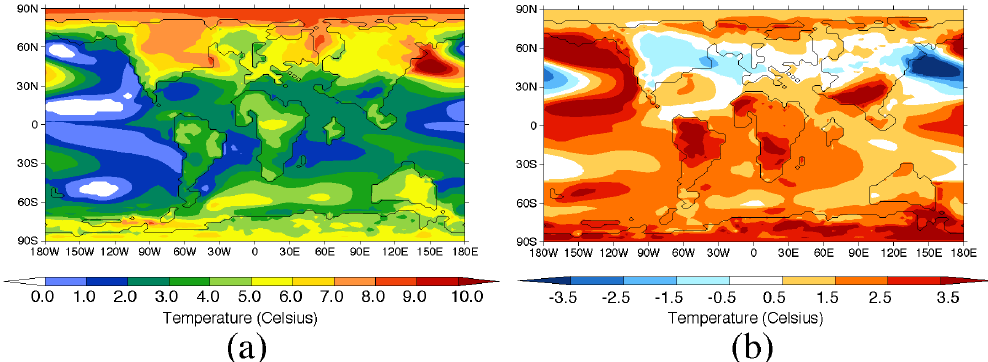
Fig. 10. Difference in annual surface air temperature when (a) CO 2 is doubled but vegetation is fixed (4 × FIXED − 2 × DYN) and (b) CO 2 is constant but vegetation distribution changes (4 × DYN − 4 × FIXED). Only differences at the 95% confidence level are